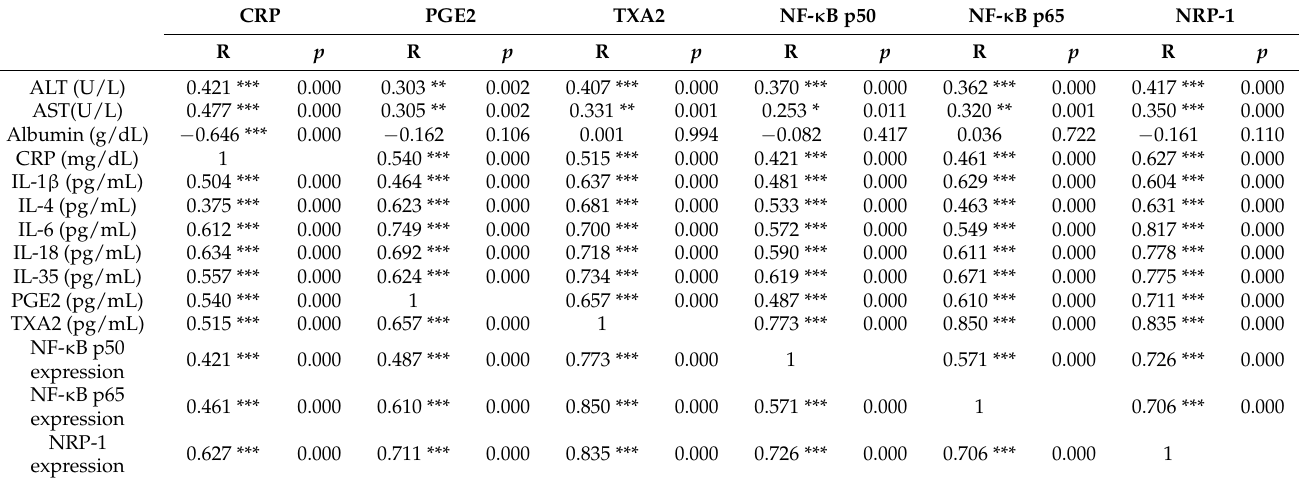
Table 2. Correlation between CRP, PGE2, TXA2, NF- κ B p50, NF- κ B p65 and NRP-1 with all parame- ters in the moderate